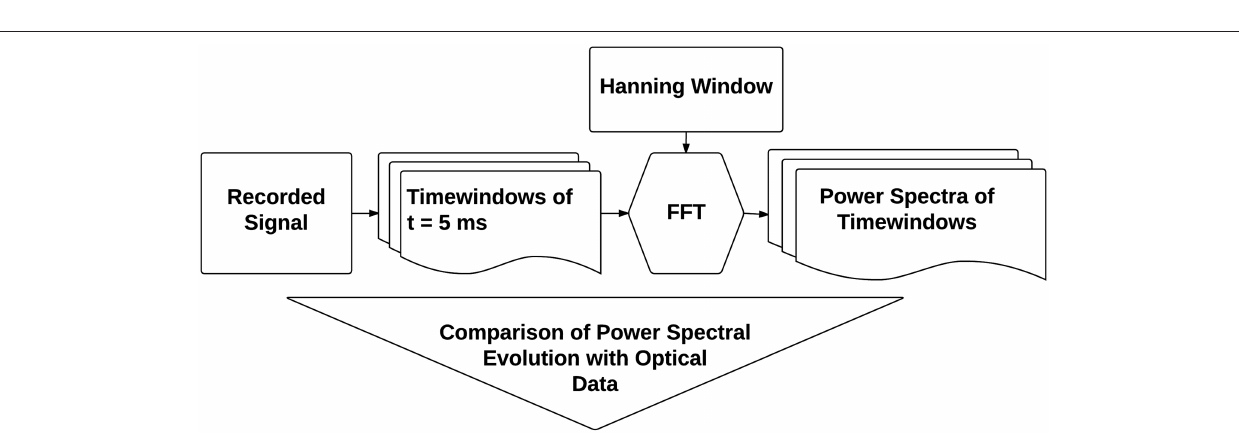
acquired via the fast speed camera. The acoustic recordings at the same time step are shown in Figure 5 . The air injection starts at t 0 s. = Before injection, only ambient electrical noise in the recording system is present. Its power spectrum is flat ( Figure 5 , Right, Blue Curve). After correction with the sensor response the mechanical response ( Figure 5 , Right, Red Curve) is